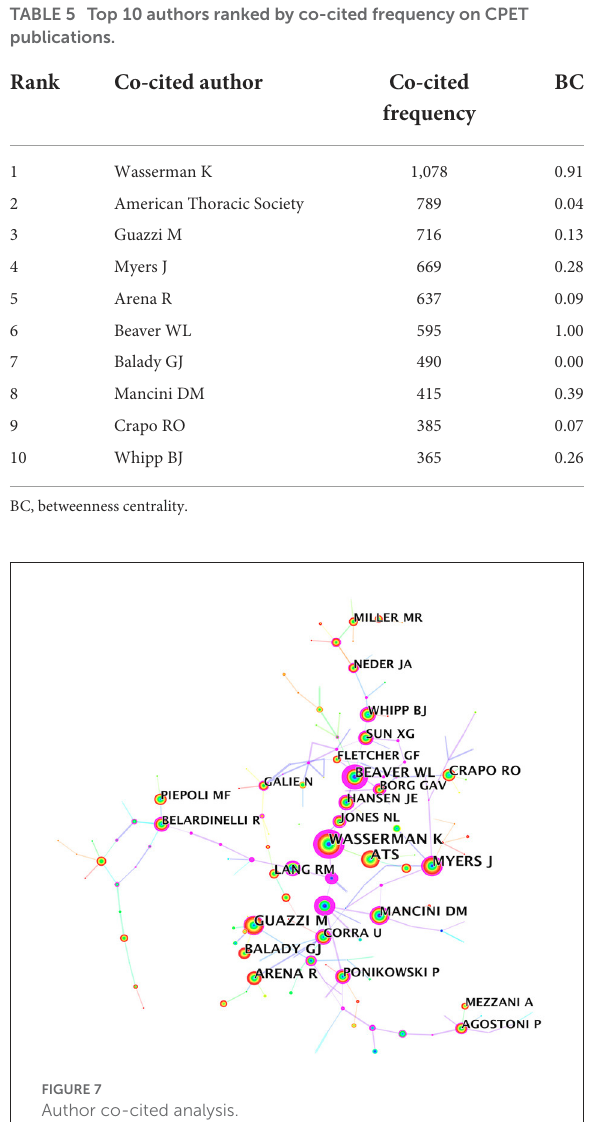
were the main applied subjects of CPET. Sport sciences and physiology were interdisciplinary subjects involved in